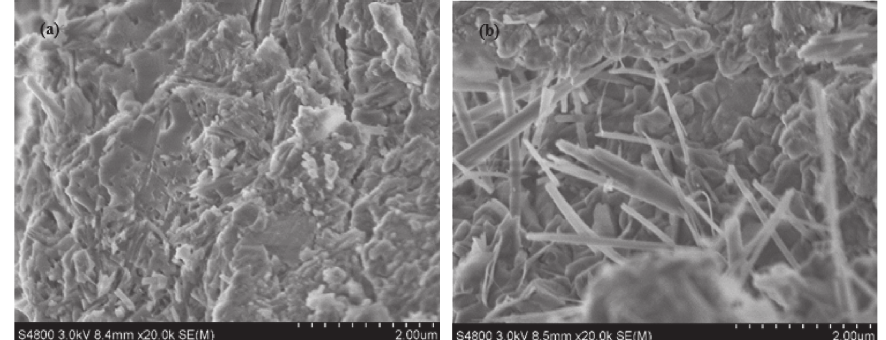
Figure 3: ESEM pictures of cement paste at a curing age of 28 days: (a) paste with 10% diatomite and 3% zeolite powder; (b) paste with 10% modified diatomite and 3% zeolite powder.